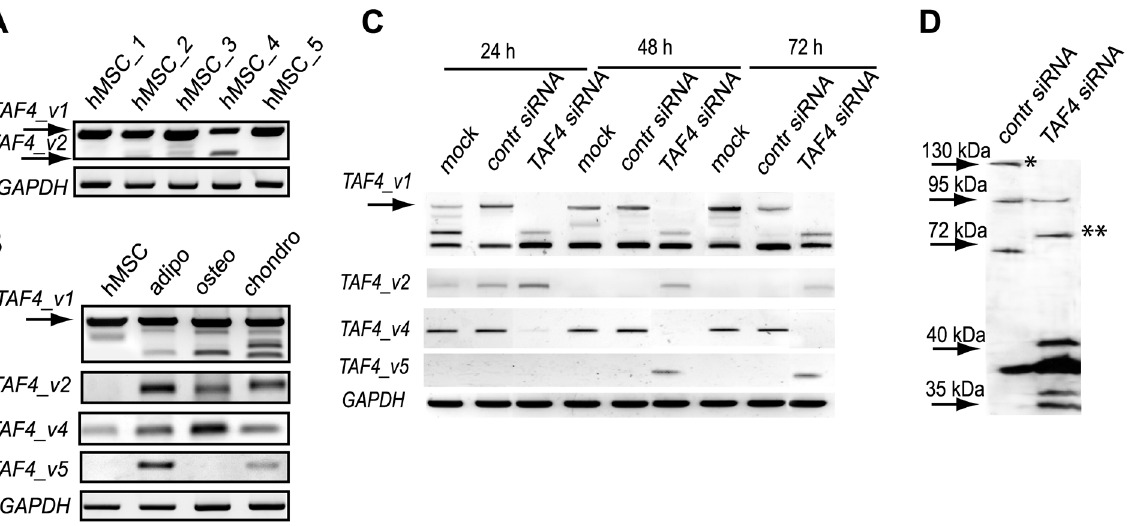
Figure 2. Expression of TAF4 splice variants and isoforms in human MSCs differentiated into adipocytes, osteoblasts or chondrocytes and treated with TAF4 RNAi. ( A ) RT-PCR analysis of different individual hMSCs clones (hMSCs 1–5) using TAF4_v1a (full length) specific primers (see Table S2). Expression of GAPDH mRNA is shown at the bottom. ( B ) Expression of TAF4 ASVs encoding proteins with compromised hTAF4-TAFH domain is dominant in differentiated hMSCs. RT-PCR analysis using TAF4 ASV-specific primers was performed 7 days after induction of differentiation of hMSCs towards adipo-, osteo- and chondrogenic lineages. GAPDH mRNA expression was used for the normalization. ( C ) Expression of TAF4 ASVs following treatment of human MSCs with control and hTAF4-TAFH-domain targeting TAF4 siRNAs. Cells were treated with TAF4 or control siRNAs at the indicated time points and RT-PCR analysis performed using TAF4 ASV-specific primers. Analysis of GAPDH mRNA expression was used for normalization. ( D ) siRNA-mediated silencing targeting TAF4 exons V or VI induces changes in the expression of TAF4 protein isoforms as detected at 48 h post-treatment using Western blot analysis. The asterisk indicates the canonical form of TAF4 protein with the molecular weight of 135 kDa, two asterisks indicate TAF4_v2 isoform with a calculated molecular weight of about 73 kDa.